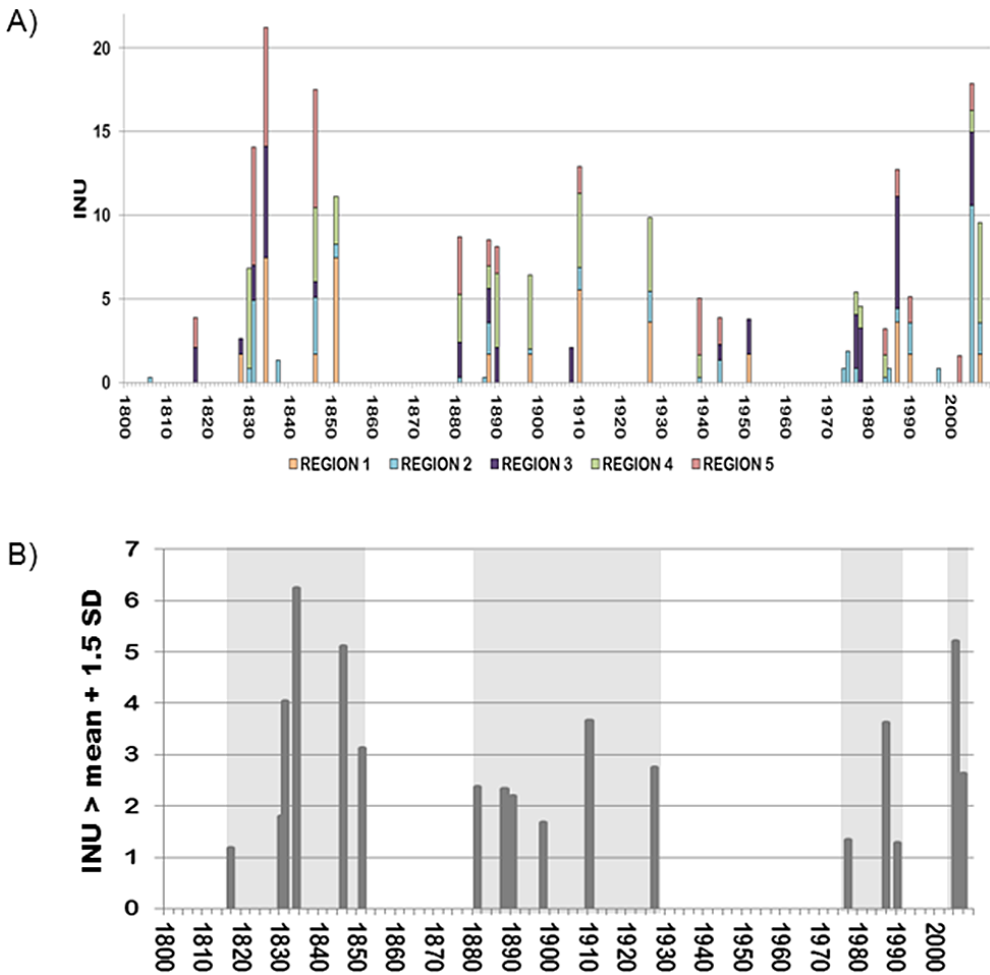
Figure 3. (a) Regional flood damage index INU for the period 1800–2009. (b) Values of INU that exceed 1.5 times the standard deviation. The periods with a high frequency of flooding are shaded